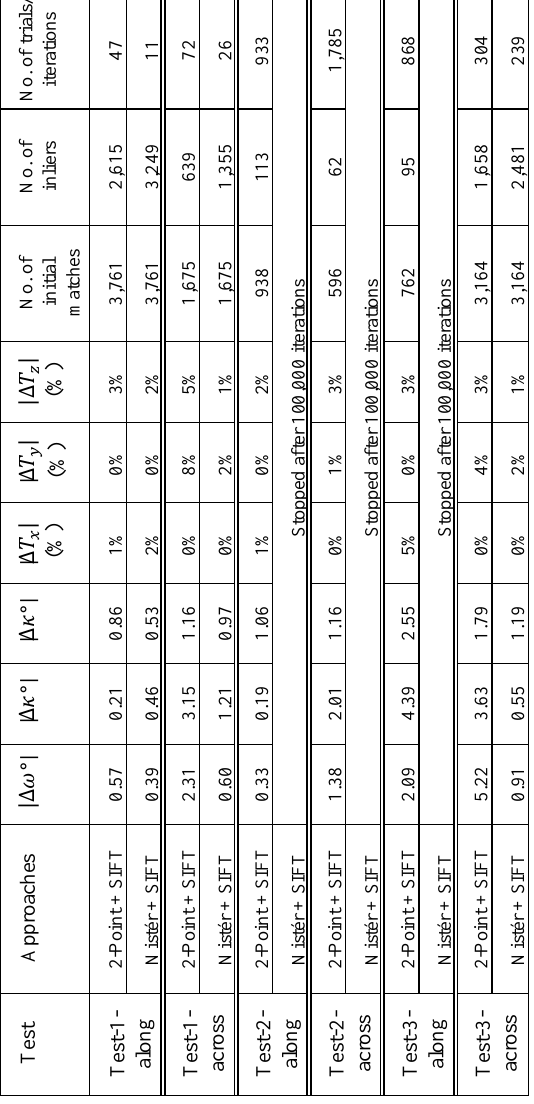
Table 1. Comparison between the estimated and true ROPs for Tests 1, 2, and